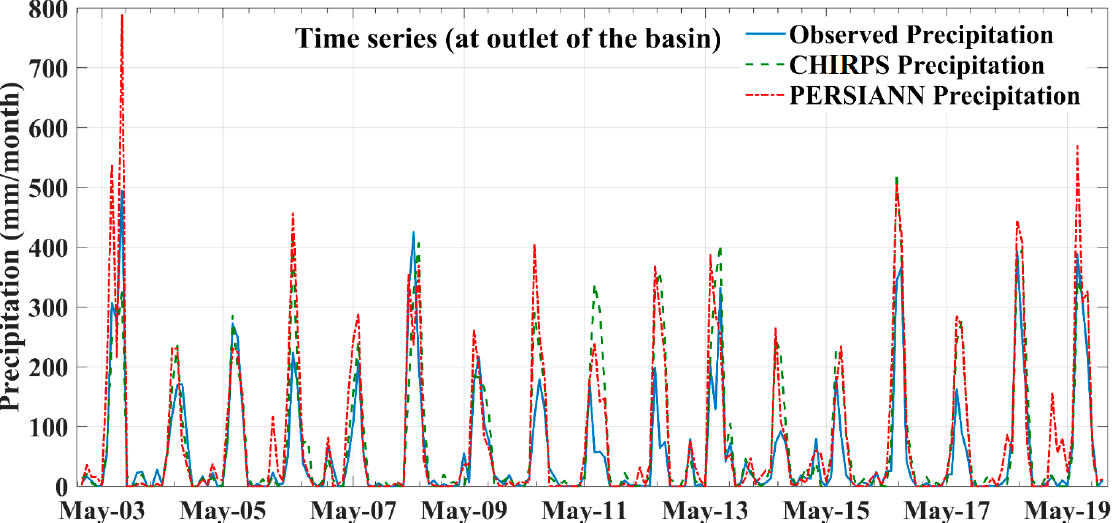
Figure 7. The time series plot of a single location at the basin outlet for observed (IMD) vs. satellite precipitations (PERSIANN and CHIRPS) datasets over a period from 2003–2019.